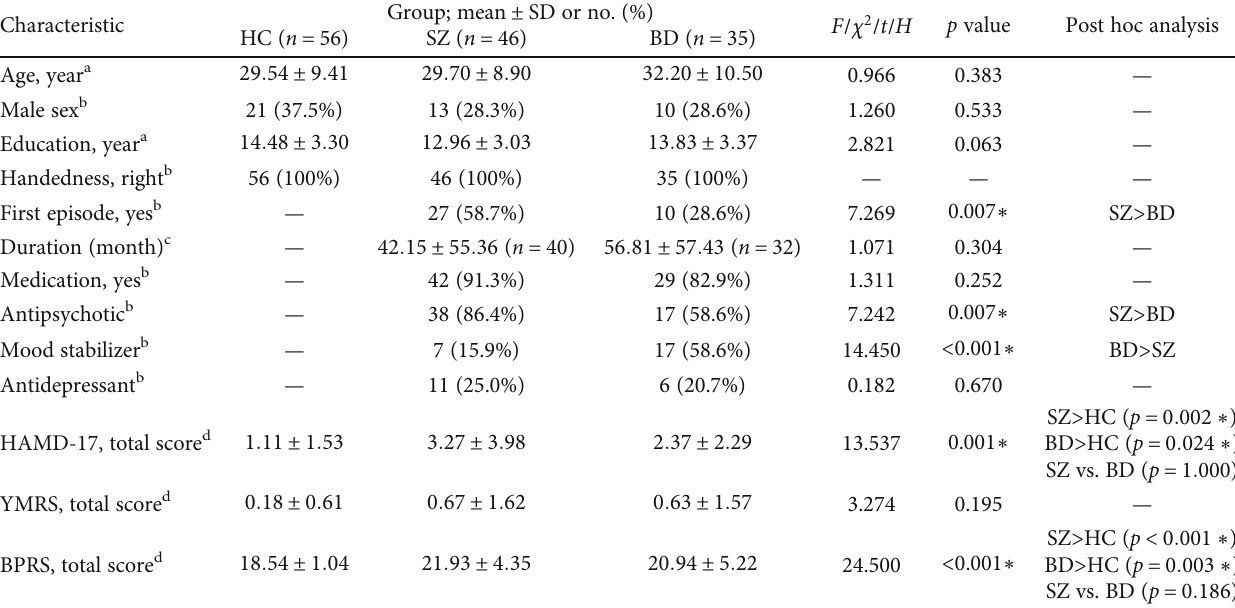
Table 1: Demographic and clinical characteristics.